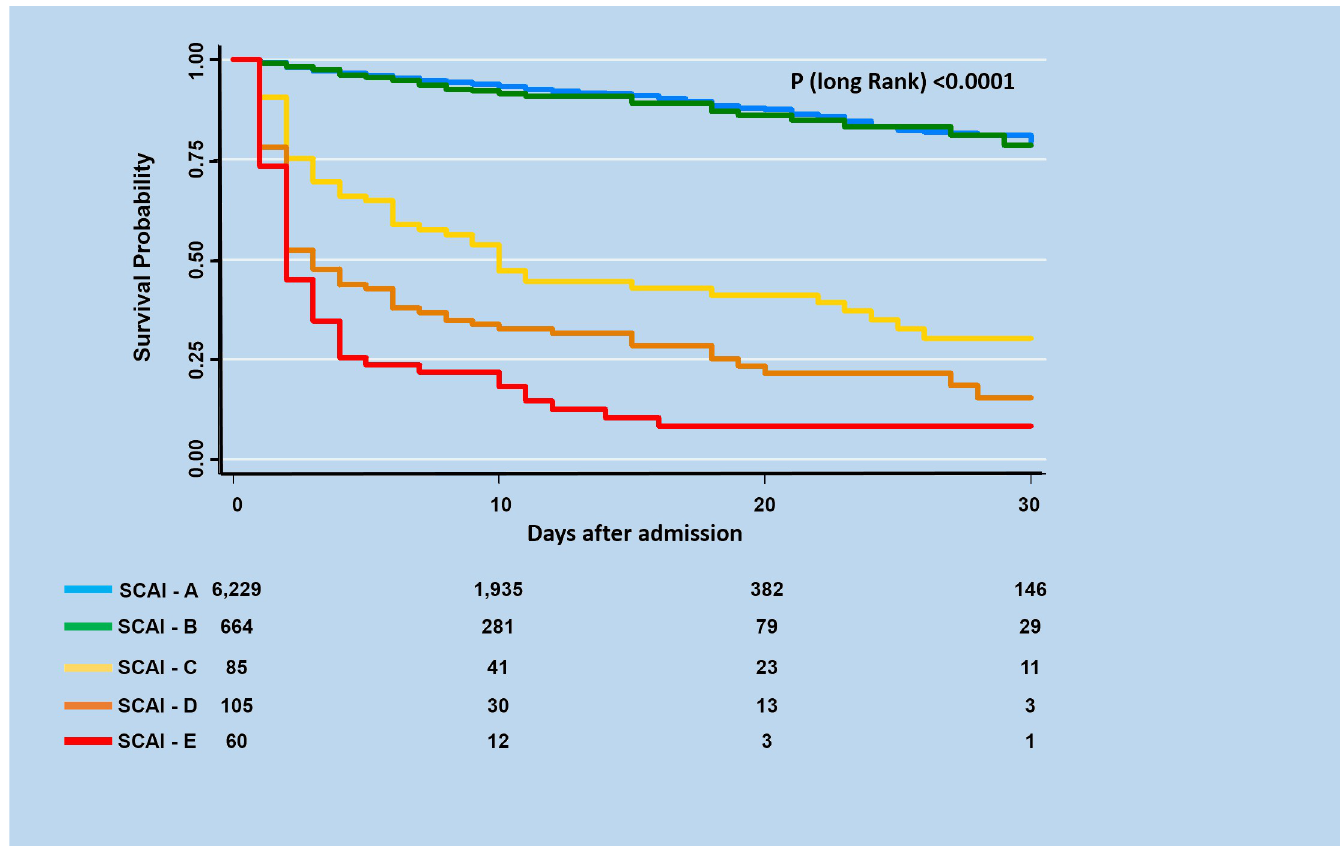
Fig 3. Kaplan-Meier survival curves for 30-day hospital survivors as a function of SCAI shock stage.